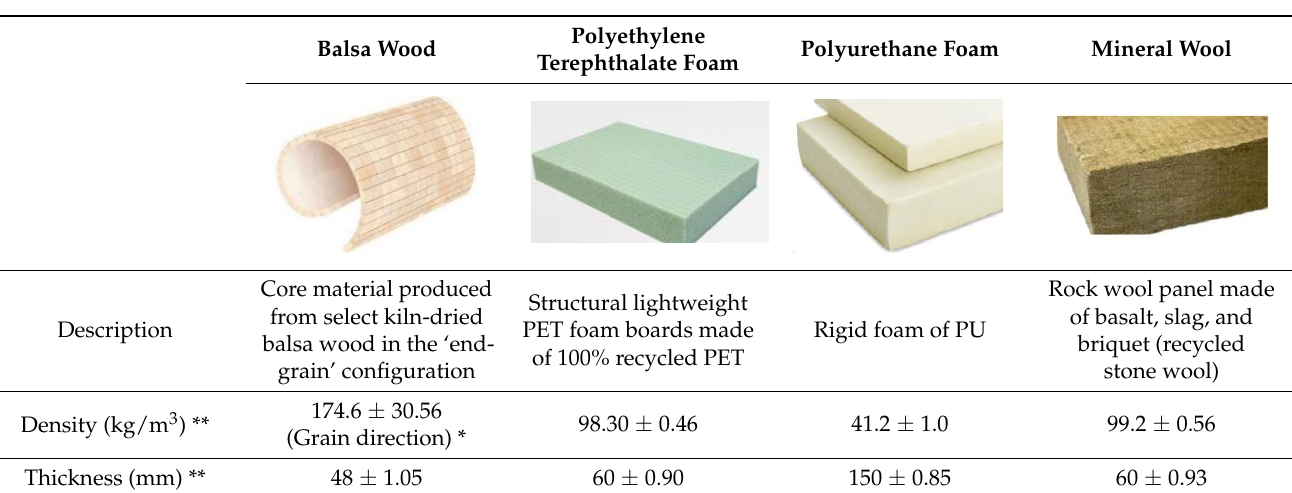
Table 1. Description of the studied materials.